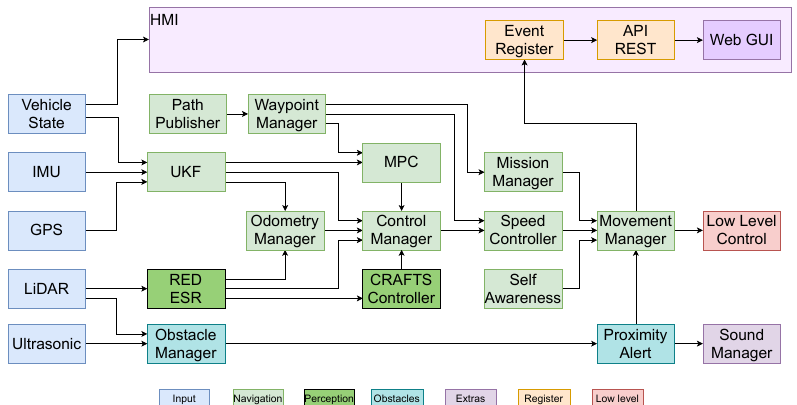
Figure 2. Ares architecture: HMI (Human Machine Interface), IMU (Inertial Measurement Unit), GPS (Global Positioning System), GUI (Graphical User Interface), API REST (Application Program Interface—Representational State Transfer), RED (Road Edge Detection), ESR (Edge Synchronized Regression) and MPC (Model Predictive